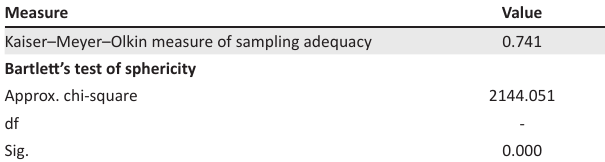
TABLE 5: Kaiser–Meyer–Olkin and Bartlett’s